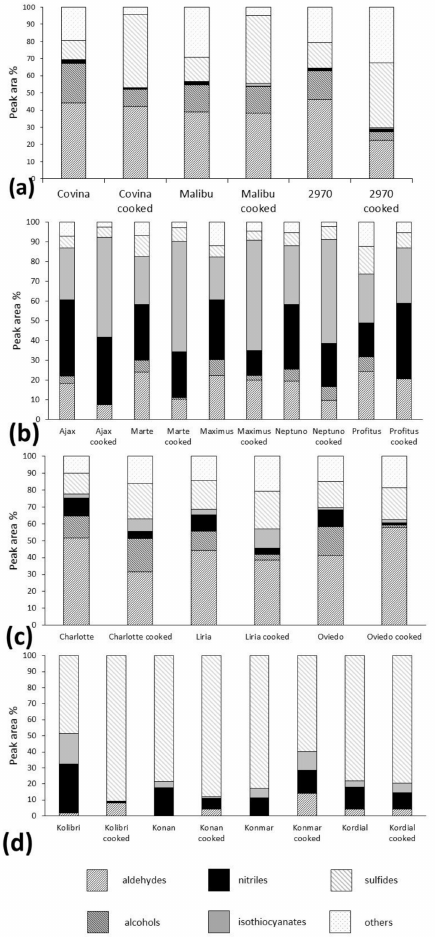
Figure 2. Percentage contents of isothiocyanates, alcohols, aldehydes, other sulfur compounds, nitriles, others (miscellaneous) in all analyzed samples. Broccoli ( a ): Covina, Malibu, “2970”; Brussels sprouts ( b ): Ajax, Marte, Maximus, Neptuno, Profitus; Cauliflower ( c ): Charlotte, Liria, Oviedo; Kohlrabi ( d ): Kolibri, Konan, Konmar,